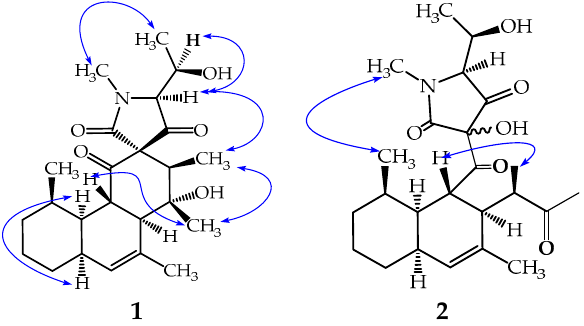
Figure 3. Key ROESY correlations of simplicilones A ( 1 ) and B ( 2 ).